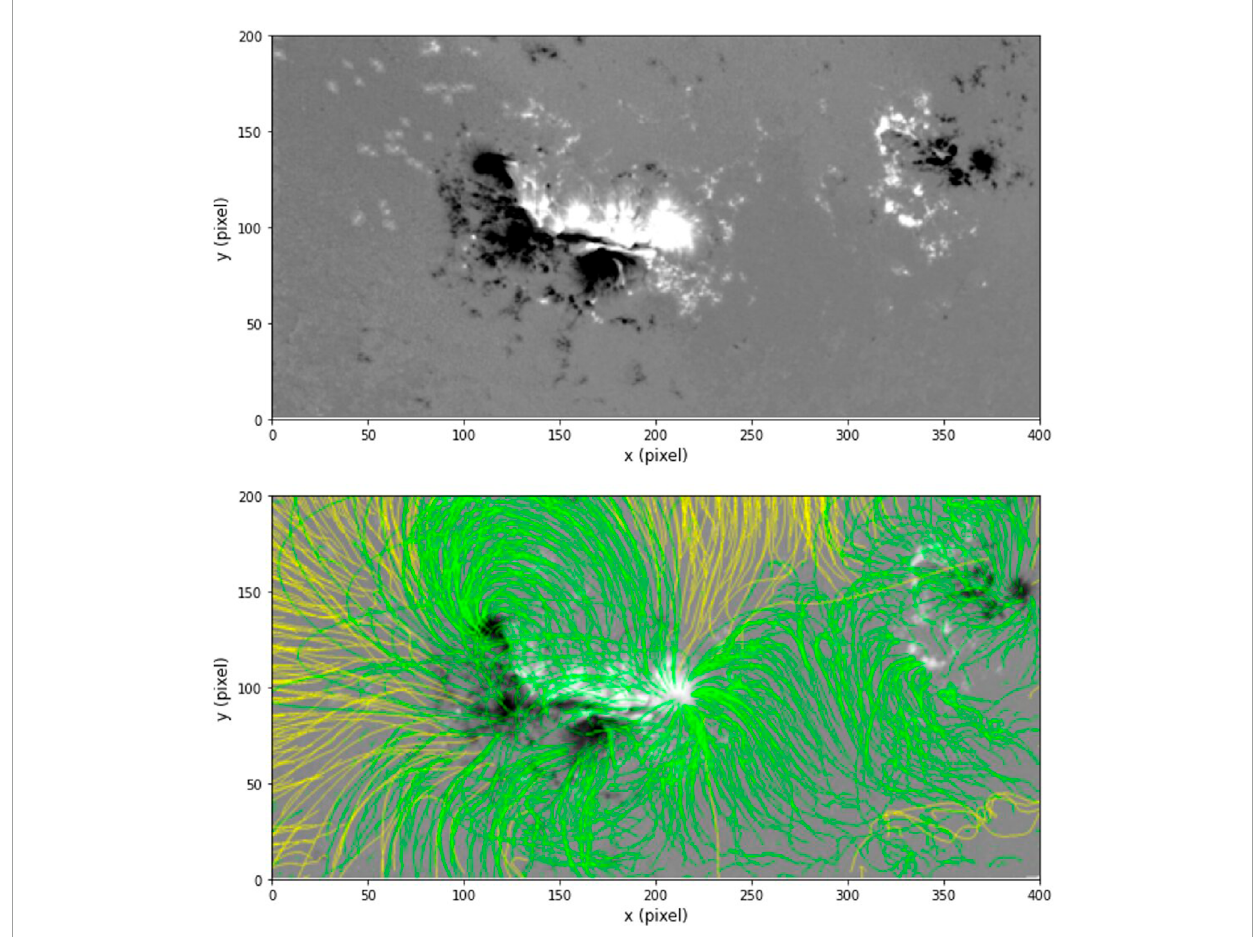
FIGURE 1 (Top) The HMI measured magnetogram from 2012-03-07 00:00UT. (Bottom) The NLFFF extrapolated from the 00:00UT